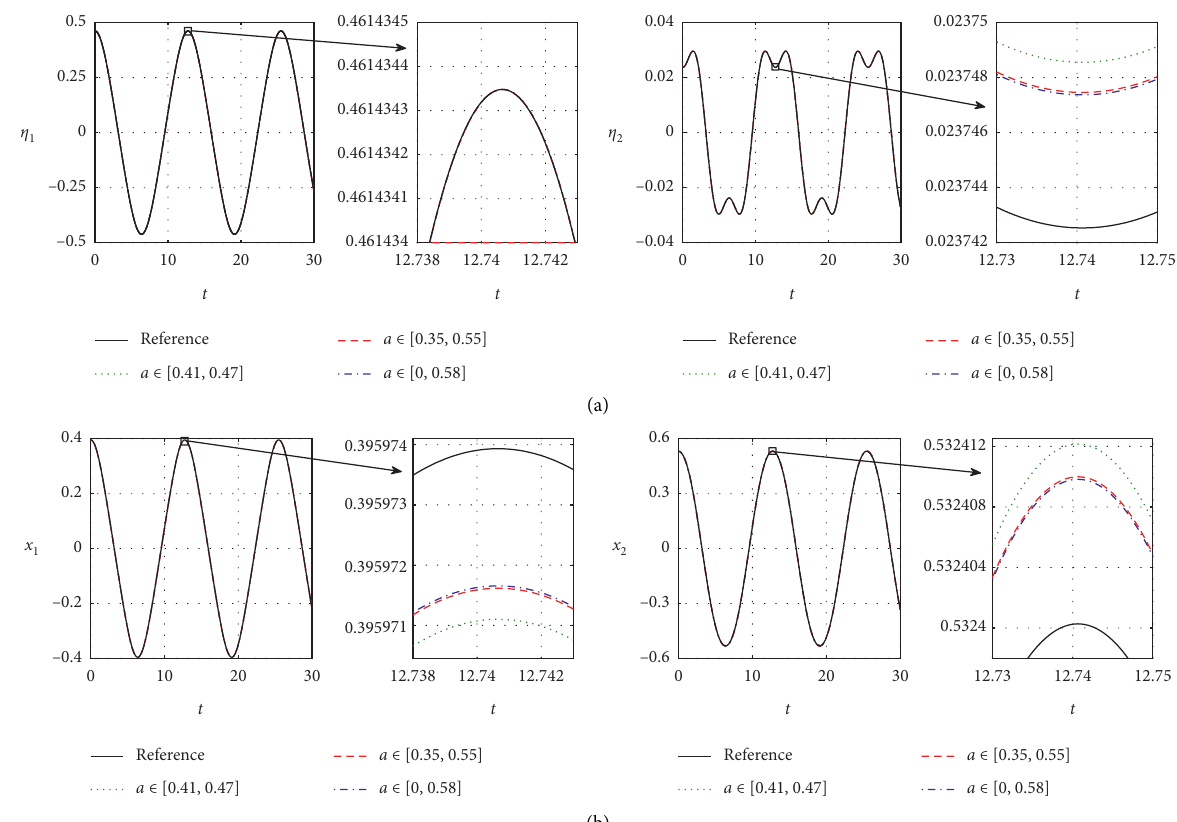
Figure 6: Periodic responses from various approximate invariant manifolds. Top plots: (a) response η and the corresponding close-up plots of the square regions; bottom plots (b) response x corresponding close-up plots of the square regions. Reference solution is given as solid lines; the solution from manifold of domain ( a, ϕ )| a ∈ [ 0 . 41 , 0 . 47 ] , ϕ ∈ [ 0 , 2 π ] 􏼈 􏼉 is given as green dotted lines; the solution from manifold of domain ( a, ϕ )| a ∈ [ 0 . 35 , 0 . 55 ] , ϕ ∈ [ 0 , 2 π ] 􏼈 􏼉 is given as red dashed lines; the solution from manifold of domain ( a, ϕ )| a ∈ [ 0 , 0 . 58 ] , ϕ ∈ [ 0 , 2 π ] 􏼈 􏼉 is given as blue dashed-dotted